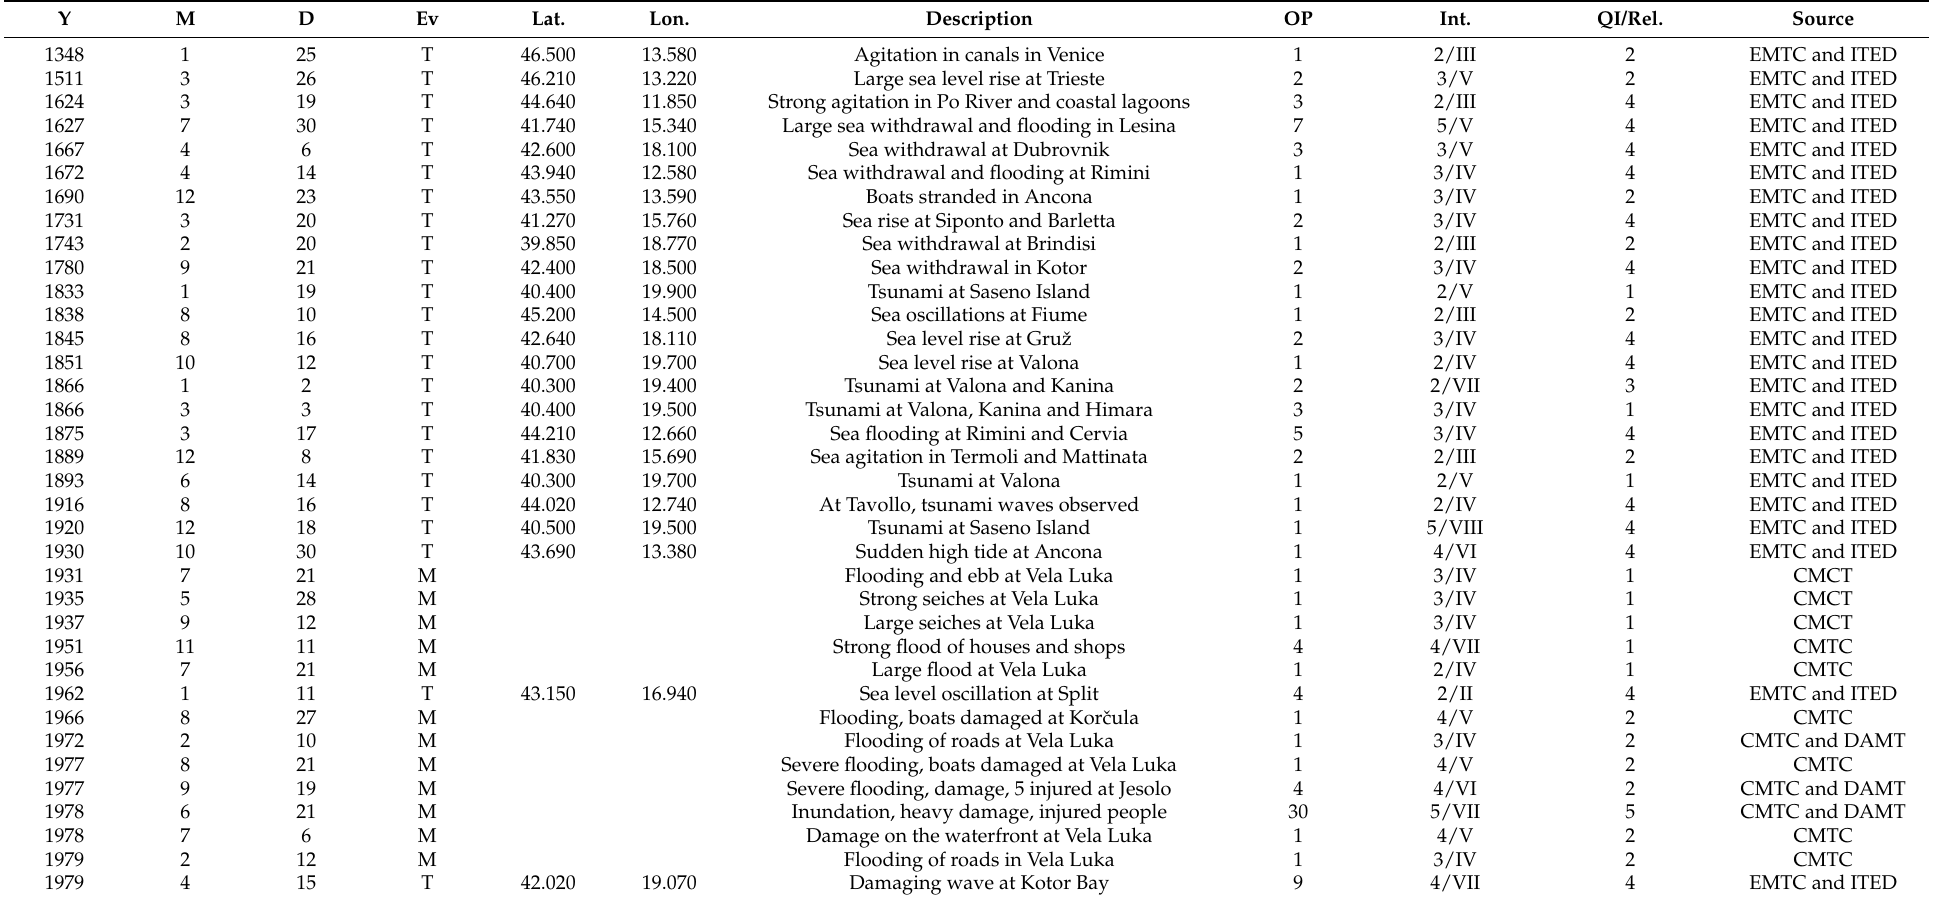
Table 1. List of the events included in DAMT with the main parameters. Y = year, M = month, D = day of the event, Ev = type of event (T = tsunami; M = meteotsunami), Lat.-Lon. = coordinates of the tsunamigenic earthquake, Description = short description of the main effects, OP = number of observation points where effects were observed; Int. = maximum intensity of the event, where the first number is the value according to the Ambraseys–Sieberg scale and the roman number is the value according to the Papadopoulos–Imamura scale, QI/Rel. = quality index (meteotsunami) and relibility (tsunami), and Source = catalogue from which the data were mainly